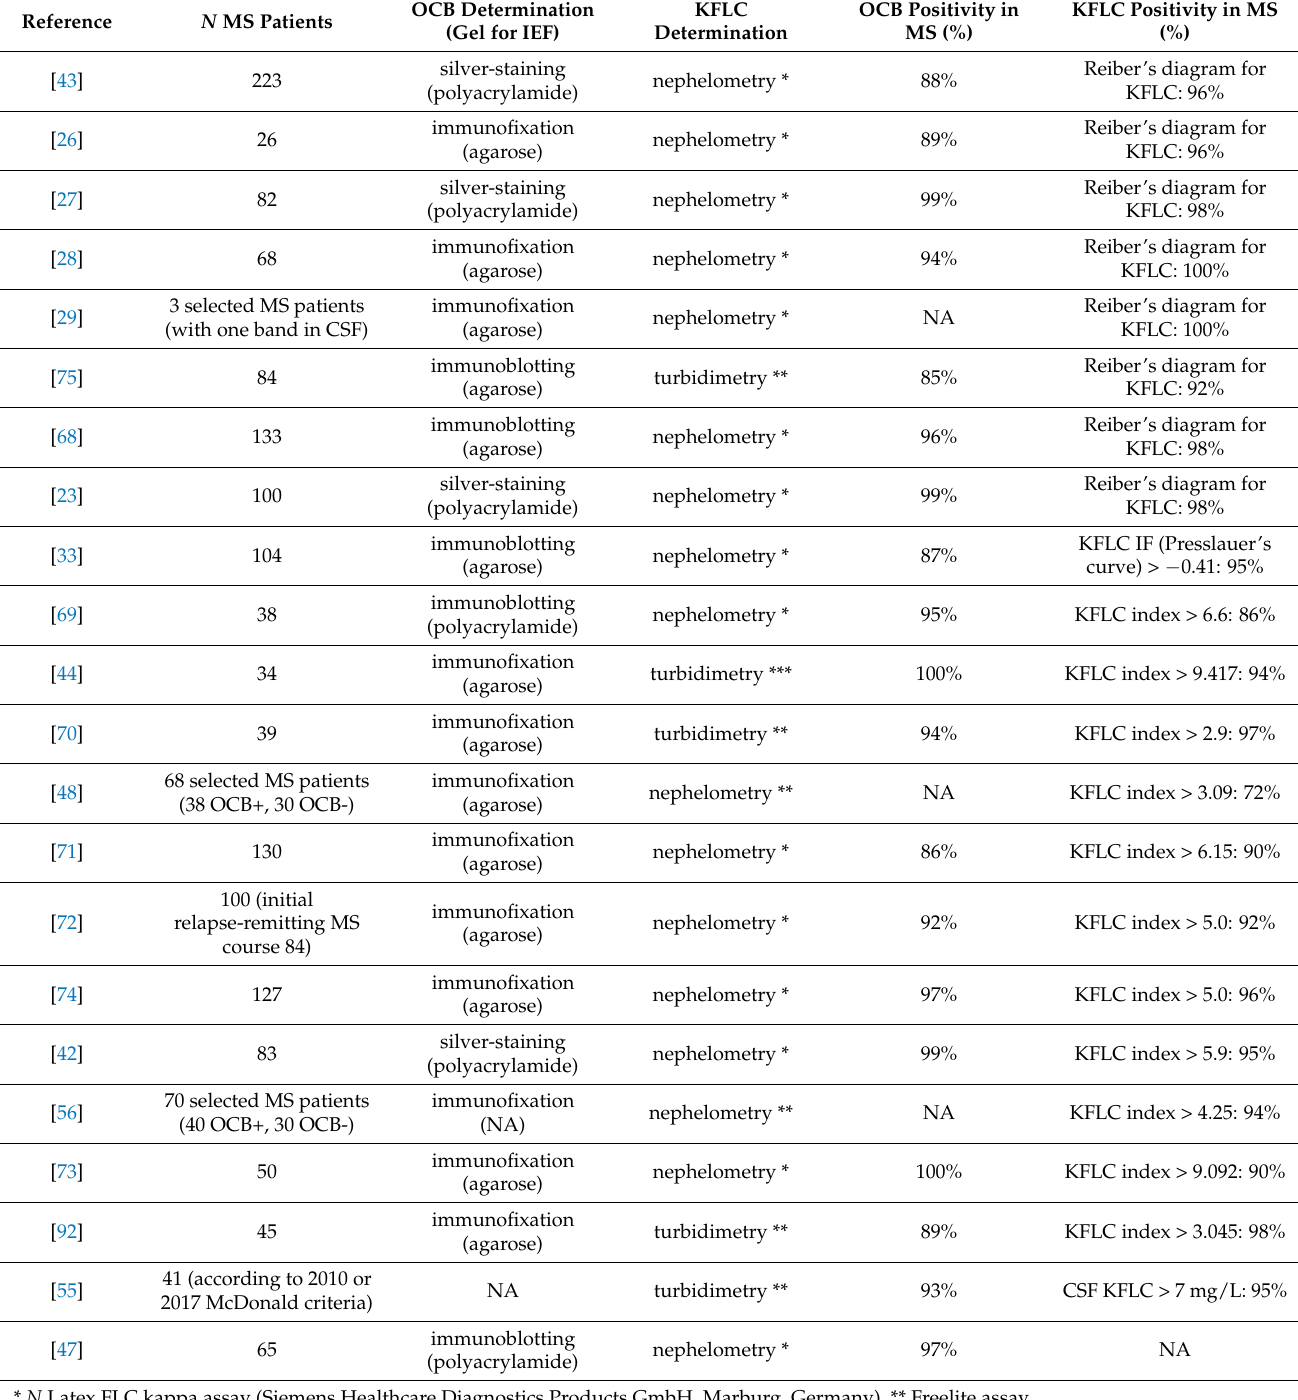
Table 3. Kappa free light chain (KFLC) determination in multiple sclerosis (MS) patients according to the revised McDonald criteria of